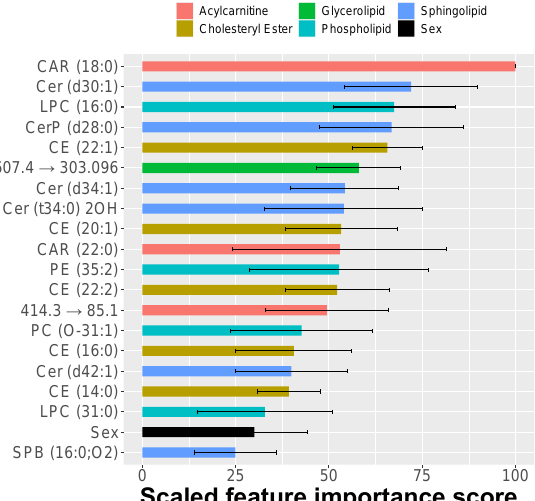
Figure 5. The most predictive skin lipid features for CAD identified by elastic-net-regularized logistic regression. The features include the animals’ sex, underscoring the importance of sex difference in CAD occurrence and diagnosis. The feature importance is expressed as the scale version of the absolute value of the coefficients in the tuned elastic-net model. The training of the model was repeated ten times, and the whiskers illustrate the observed standard deviations.